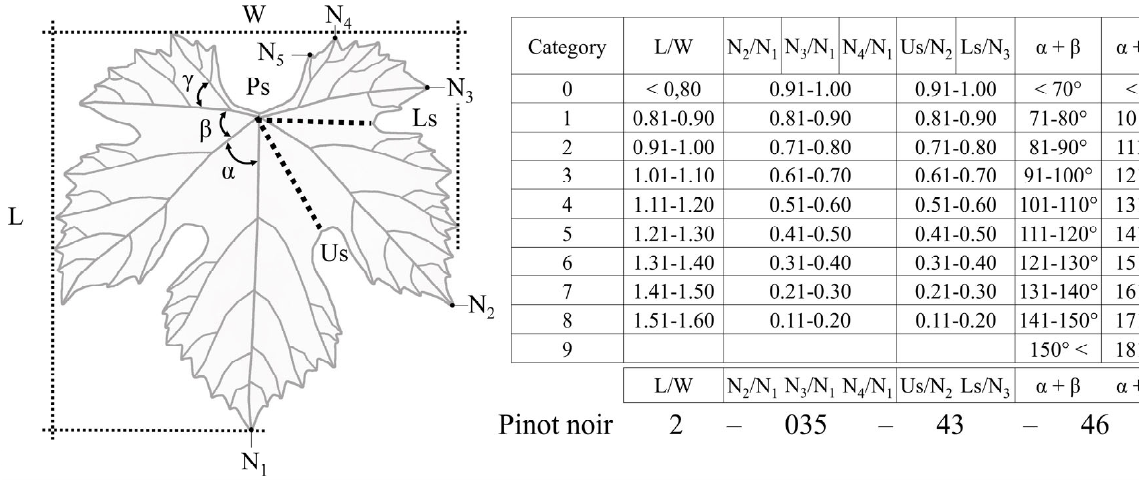
Figure 3. Ampelometric features and index according to N é meth [51]. Nomenclature of the ampelo- metric traits is not uniform in the literature, for example, indication of the veins is different. In this study, we follow the OIV [7] descriptor list, where the veins are indicated with “N” which is identical to abbreviation “L” in Ravaz [10] and Galet [39], and “E” in N é meth [51] numbered from 1 to 5.